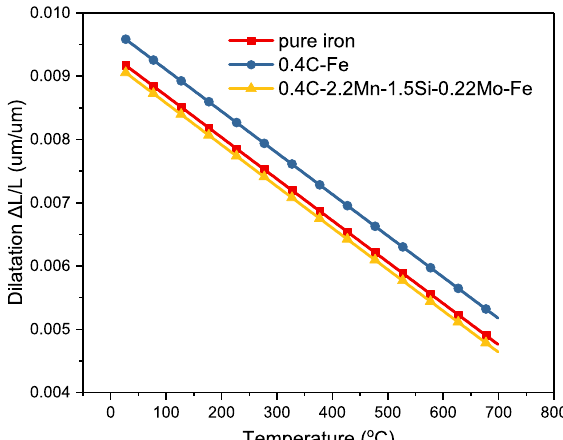
Figure 5. Relative change of length in two steels and pure iron as a function of temperature by theoretical calculation in complete transformation from face-centered cubic to body-centered cubic crystal